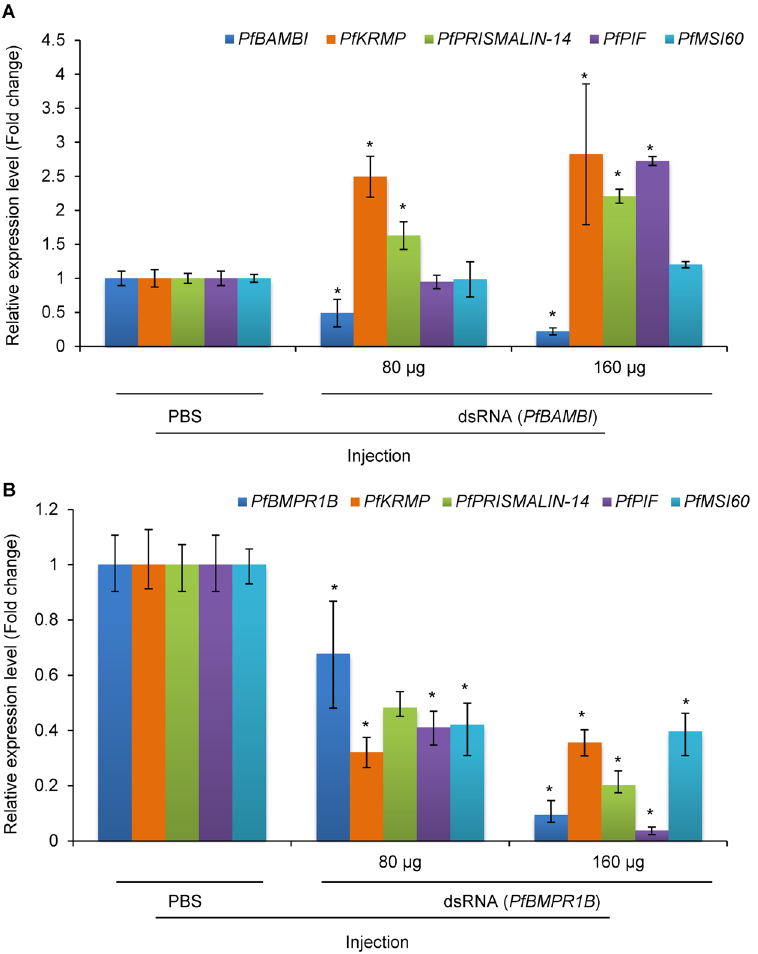
Figure 7. The relative expression levels of PfBMPR1B , PfBAMBI and shell matrix protein (MP) genes inhibited by RNA interference. ( A ) The expression of PfBAMBI and the MP genes PfKRMP , PfPRISMALIN-14 , PfPIF and PfMSI60 after injecting 80 and 160 μ g of double-stranded RNA (dsRNA) of PfBAMBI for 6 d. ( B ) The expression of PfBMPR1B and the MP genes PfKRMP , PfPRISMALIN-14 , PfPIF and PfMSI60 after injecting 80 and 160 μ g of double-stranded RNA (dsRNA) of PfBMPR1B for 6 d. PBS-injected groups were used as controls. * P < 0.05. Differences were assessed by one-way